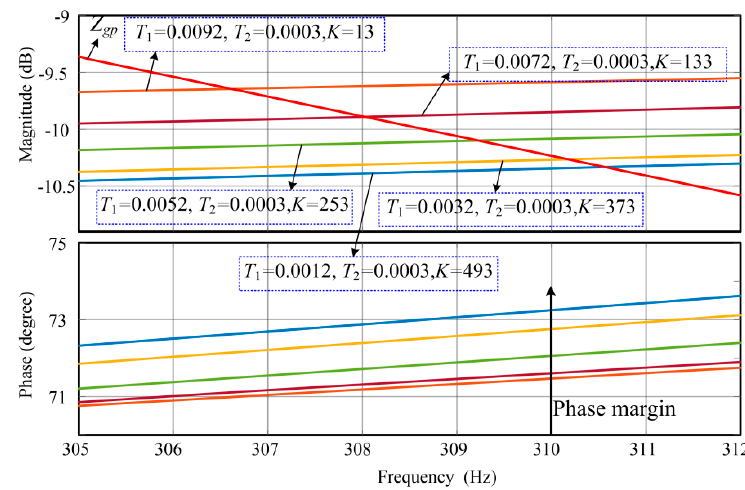
Figure 14. Bode plot of DFIG impedance and parallel compensated weak grid with different Lead/Lag PLL parameters.